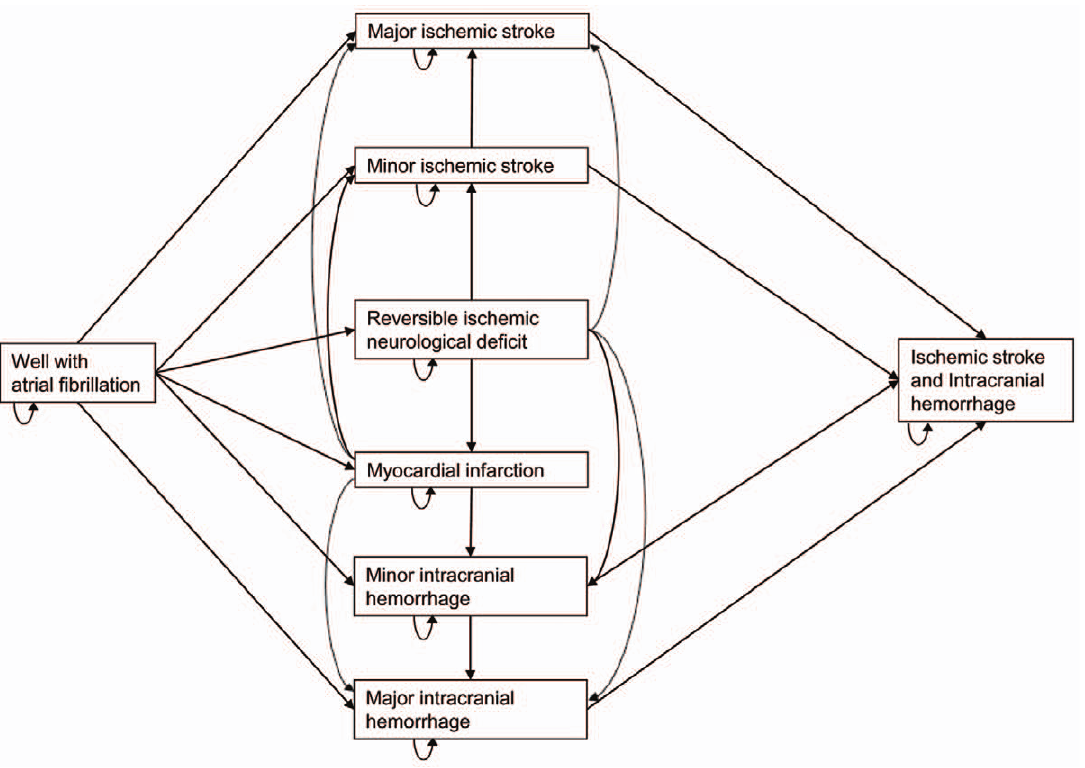
Figure 1. Simple schematic representation of the Markov model. All patients started at age 65 in the ‘‘well’’ with atrial fibrillation health state and then cycled between health states until death occurred or lifetime follow-up period ended (whichever came first). Only certain transitions were allowed and patients could never transition to a more favorable health state. The length of each cycle was 2 weeks and patients could only experience one event of any kind per cycle. Any health state could lead directly to death (not depicted). A second minor ischemic stroke resulted in a major ischemic stroke and that a second major ischemic stroke resulted in death. Temporary health states (e.g., minor bleed and non-fatal extracranial bleed) are not depicted in the figure. The health states were equivalent for apixaban and warfarin, but the probabilities, costs and utilities (quality-of-life) varied with treatment.